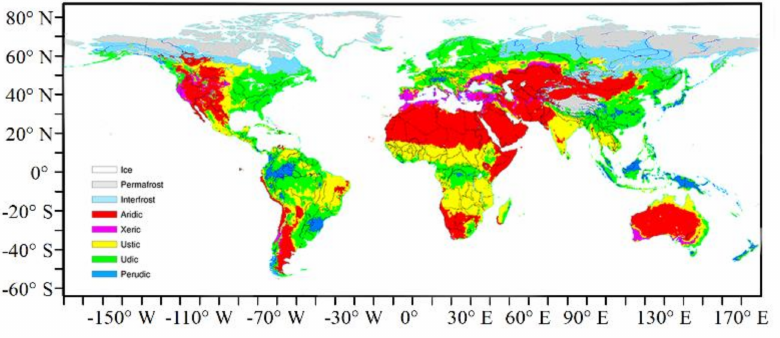
Figure 9. Resilience as a function of mean annual precipitation (MAP) and mean annual temperature (MAT) on a global scale. The black solid lines represent the mean curve from an ensemble of six curves. The dashed lines highlight the range of the individual ensemble members. The distributions of the available MAP and MAT observations are indicated by the density of the vertical lines above the x-axis.